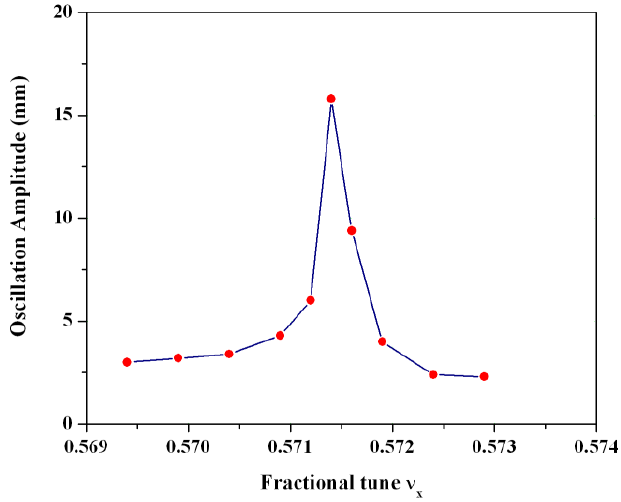
FIG. 12. (Color) Betatron oscillation amplitude of the particles driven by the TEL in the vicinity of the Q (cid:2) 4 = 7 resonance line (simulations).